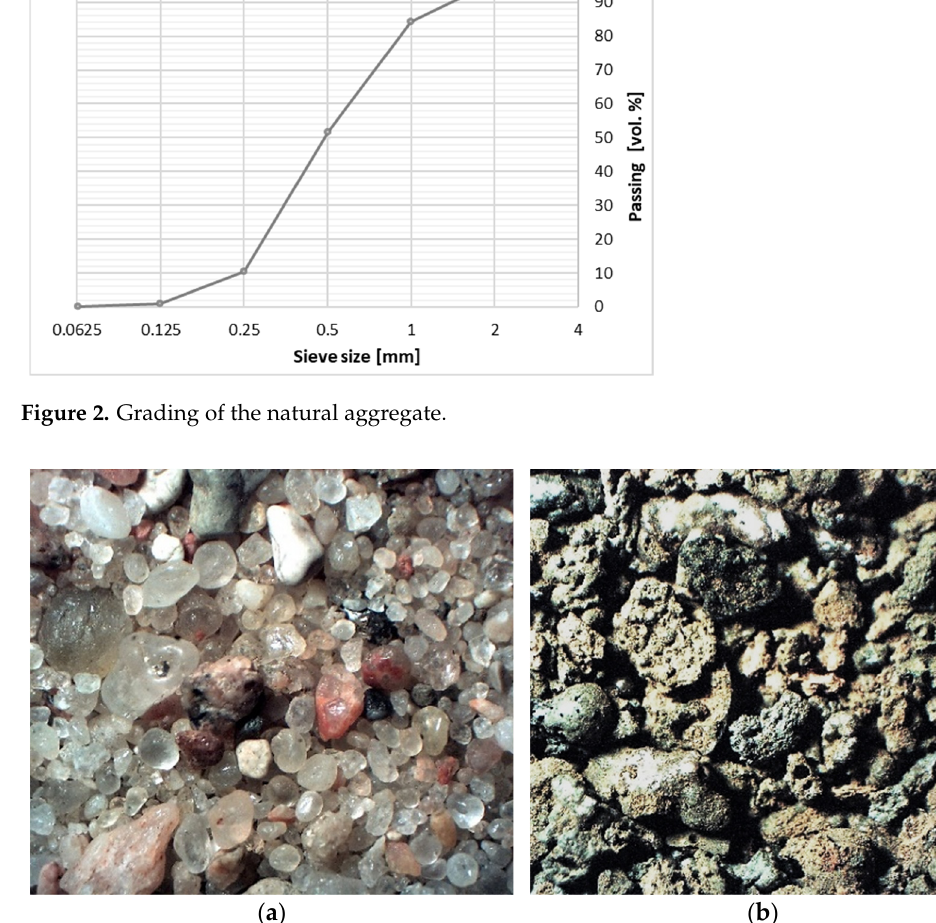
Figure 3. ( a ) Natural aggregate. ( b ) Incinerated sewage sludge aggregate (magnification of 10×).